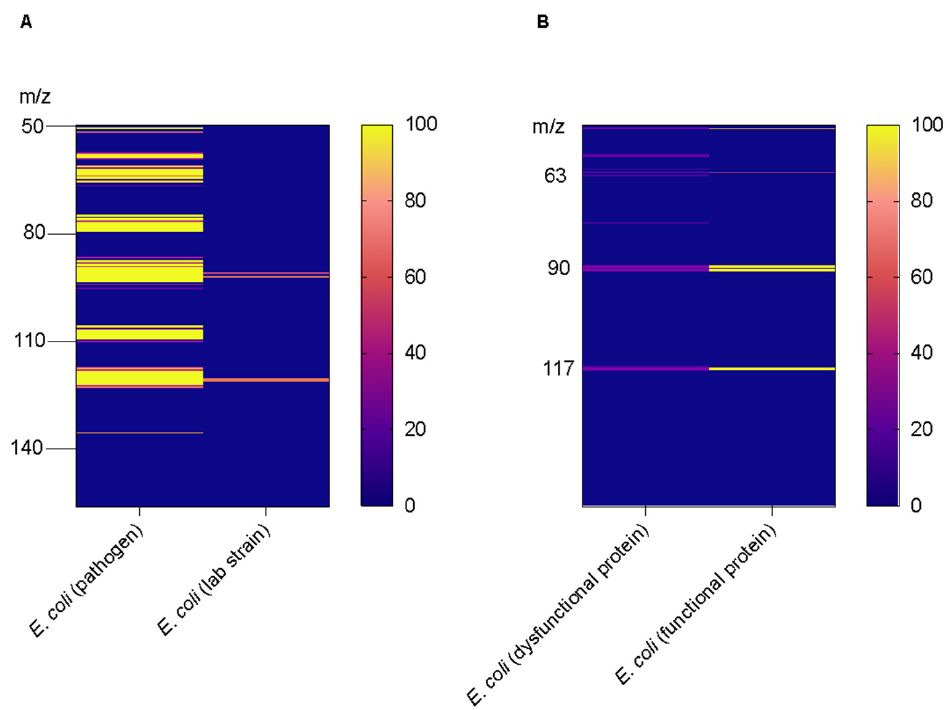
Figure 3. ( A ) Representative heatmap of undiluted overnight cultures from E. coli pathogenic and lab strains ( n = 4). ( B ) Optical density-adjusted cultures harvested 3 h after induction with IPTG ( n = 3). It was then investigated if MIMS could differentiate between the bacterial strains based on principal component analysis (PCA) (Figure 4) [29]. PCA was performed using the obtained data. This is an analytical technique used for dimensional reduction and data visualization. The mean and standard deviation of the given features were calculated. The data were then scaled using the calculated mean and standard deviation. The data were then distributed normally such that the mean was zero and had unit standard deviation. The Python inbuilt functionalities of standard scaler and fit transform were used for data standardization. The plotted principal components showed similarity and differences between datasets or samples when grouped together in clusters or when separated